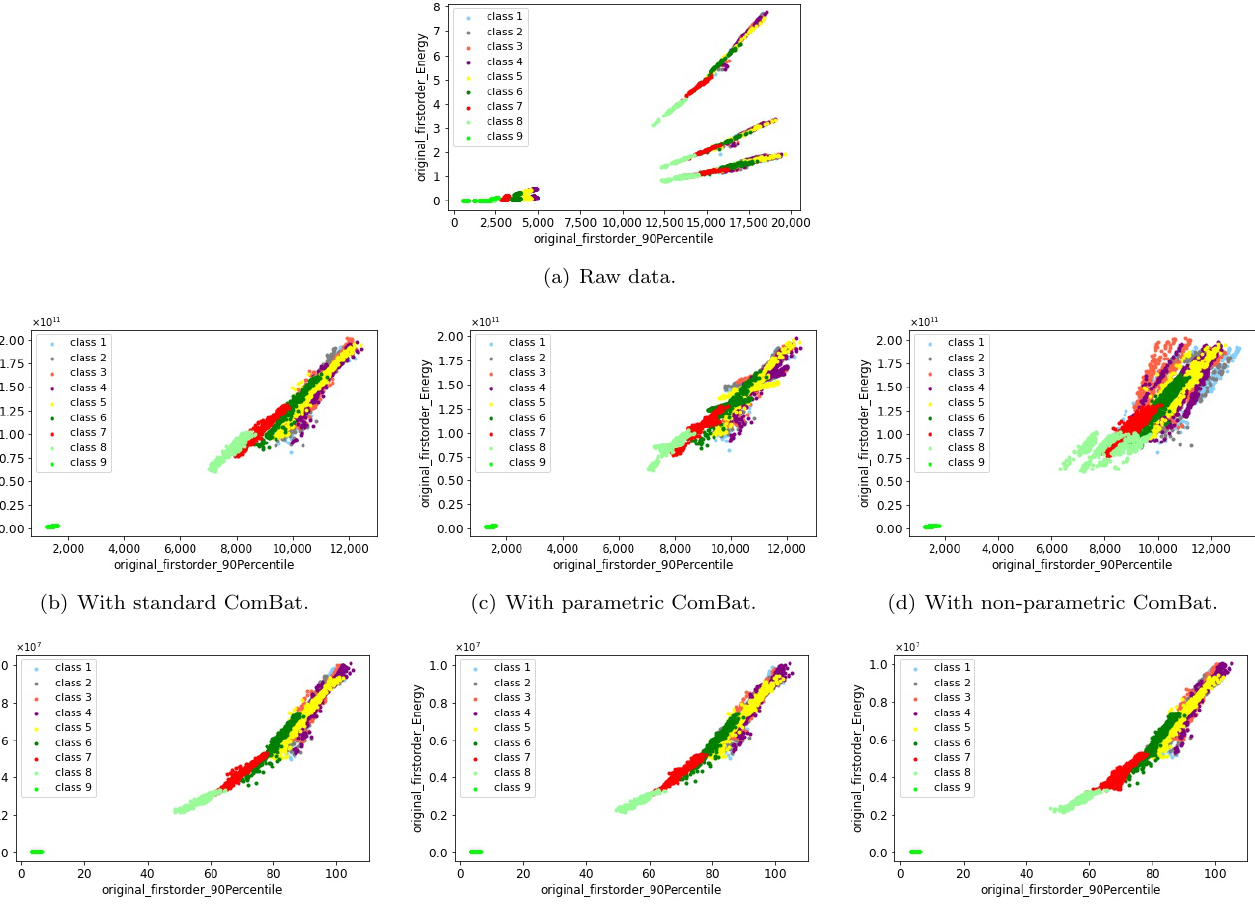
Figure 12. Visualize two features (“90th percentile” and “energy”) of the homogeneous phantom data in a 2D plane, to investigate different variants of ComBat method. Here “class 1” to “class 9” correspond to the nine homogeneous phantom tubes. The subfigures show the two example features acquired from MRI images ( a ) without applying any preprocessing and harmonization methods (raw data), ( b ) with applying the standard ComBat, ( c ) with applying the parametric ComBat, ( d ) with applying the non-parametric ComBat, ( e ) with applying the Nyúl normalization and standard ComBat, ( f ) with applying the Nyúl normalization and parametric ComBat, and ( g ) with applying the Nyúl normalization and non-parametric